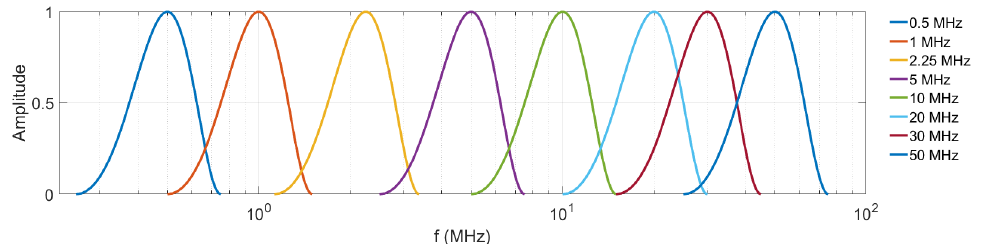
Figure 6. Simulated frequency bandwidth with left bound f l = 0.5 f and right bound f r = 1.5 f